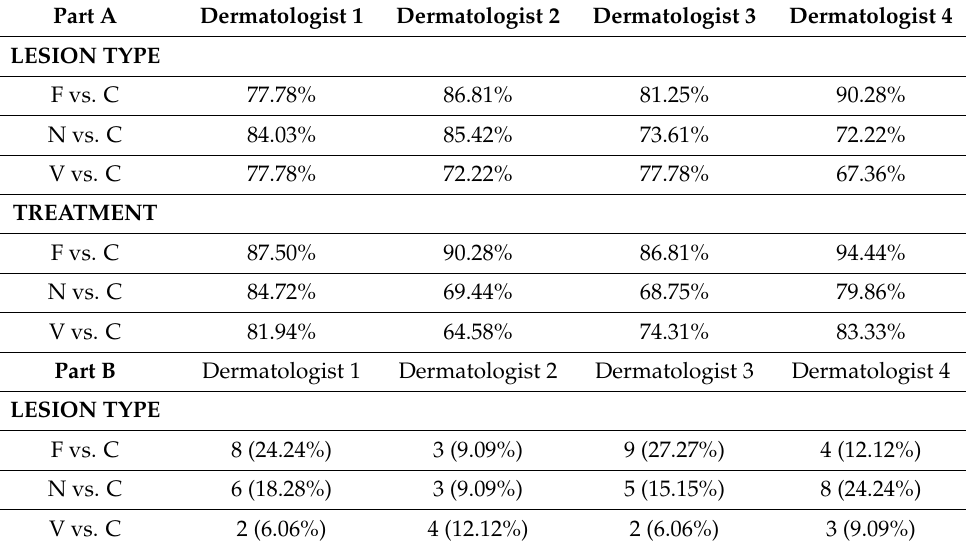
Table 3. Part A. Percentage agreement (%). Part B . Absolute number and relative percentage of “serious diagnostic